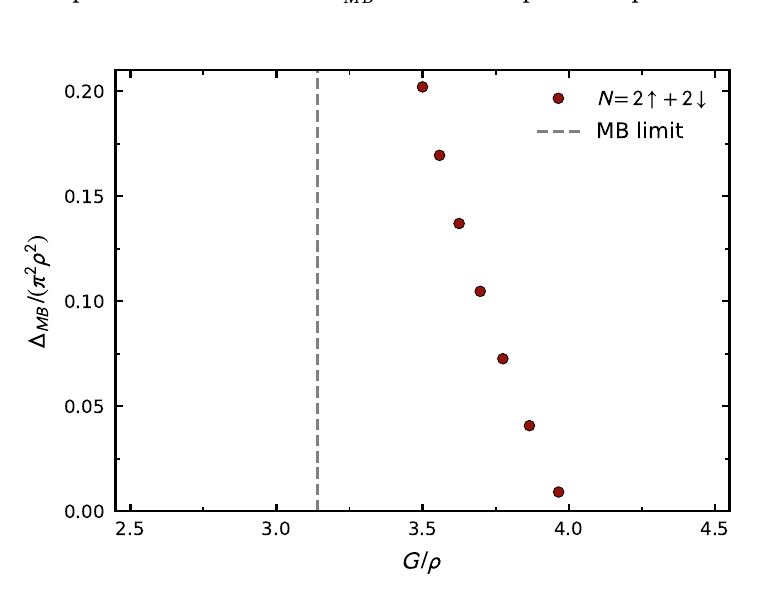
Figure 12: Comparison to many-body physics. The dashed line illustrates the tran- sition according to the Hamiltonian from Eq. (19). The dots show our data from − G plane. We used the curve for N = 2, since it ap- Fig. 5 translated into the ∆ ↑ MB pears to represent the many-body limit well. To connect ˜ g to ∆ , we used Eq. MB